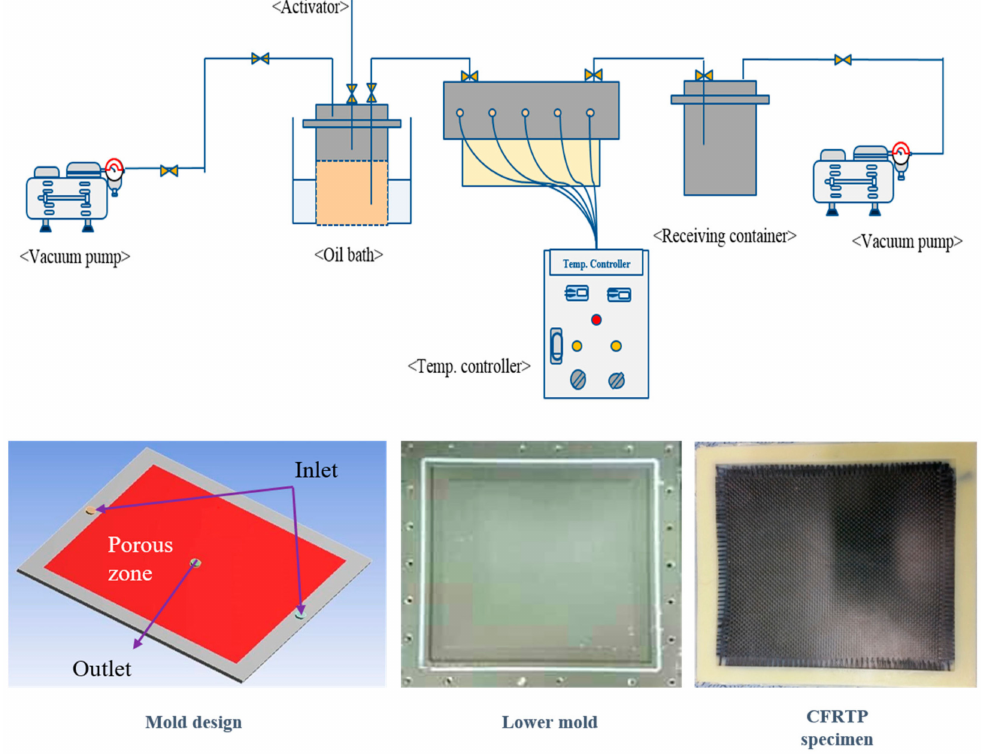
Figure 2. Schematic illustration of the VARTM